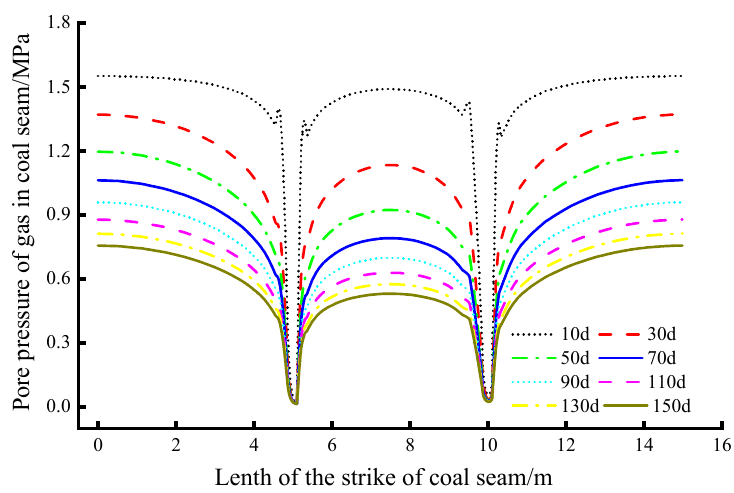
into the fissures, and merged into the borehole.